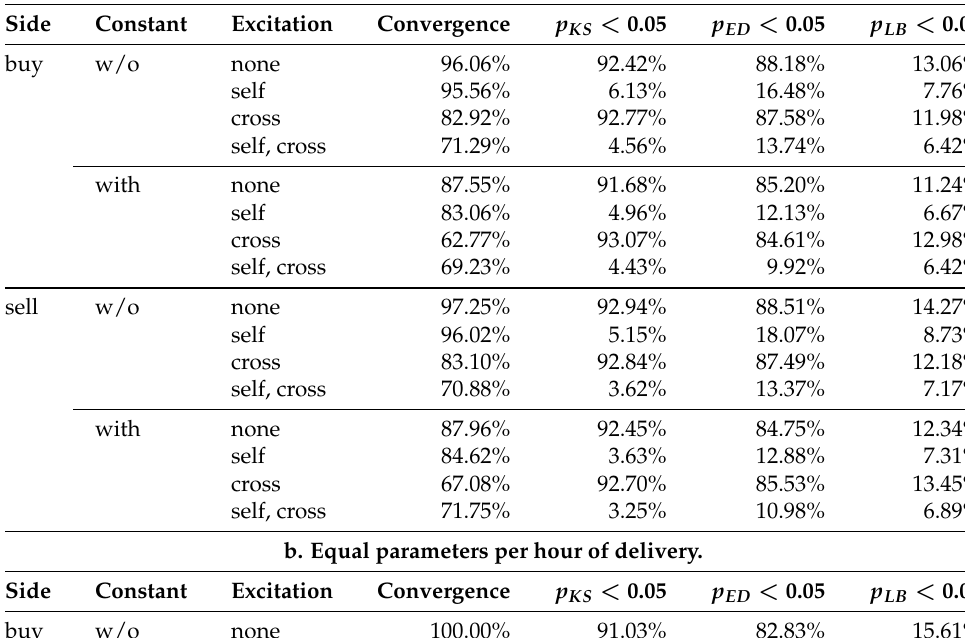
Table 1. Results of goodness-of-fit tests for the marginal processes. The column “side” specifies whether buy or sell market orders (MOs) are considered, “constant” whether the baseline intensity comprises a constant, and “excitation” the excitation structure. Each model is estimated 2184 times. The column “convergence” comprises the shares of successful estimations. The columns “ p KS < 0.05” and “ p ED < 0.05” comprise the shares of successfully estimated models where the null hypothesis of the Kolmogorov–Smirnov (KS) and excess dispersion (ED) test is rejected at a 5% significance level, respectively. The column “ p LB < 0.05” comprises the shares of successfully estimated models where the null hypothesis of the Ljung–Box (LB) test for the first five lags is rejected at a 5% significance level. a. Individual parameters for each contract.